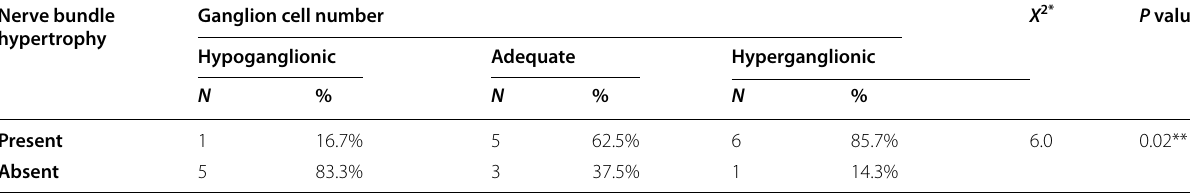
* Fisher’s exact test ** P values < 0.05 were considered statistically significant